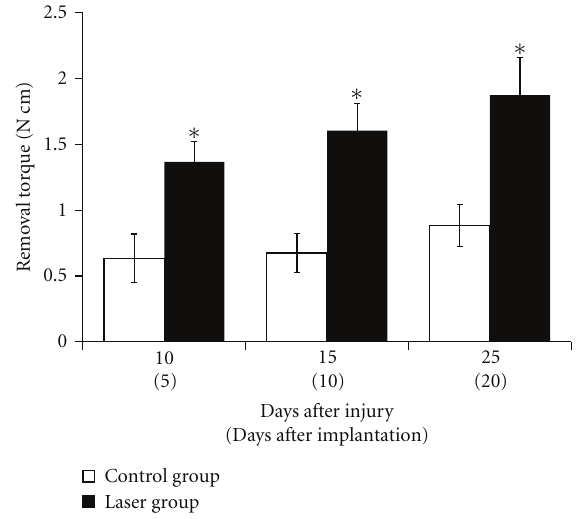
Figure 4: Removal torque examination of titanium implant. Re- moval torque values were measured at di ff erent time points. Mean ± SE (Ncm) of torque forces in laser group and control group. Five days after implantation, significant di ff erence was observed between the control and laser groups. Until twenty days after implantation, there was still a significant di ff erence between the two groups. ∗ P < 0 .